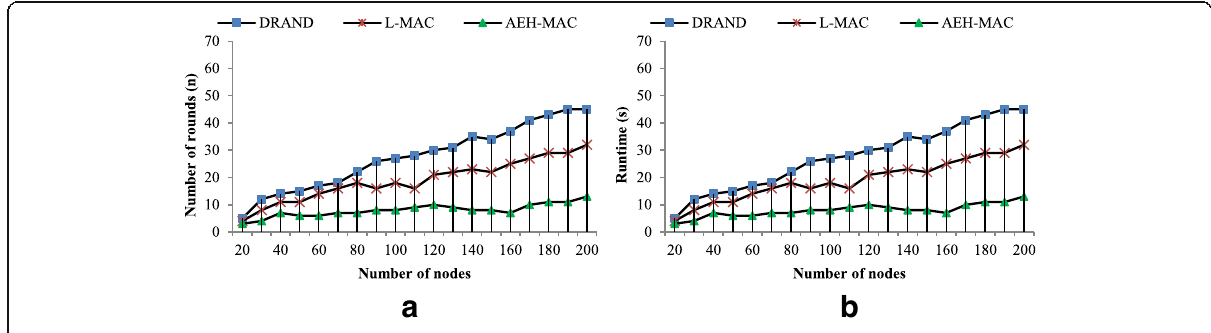
Fig. 9 One-hop performance: ( a ) Nodes vs. Rounds ( b ) Nodes vs. Runtime